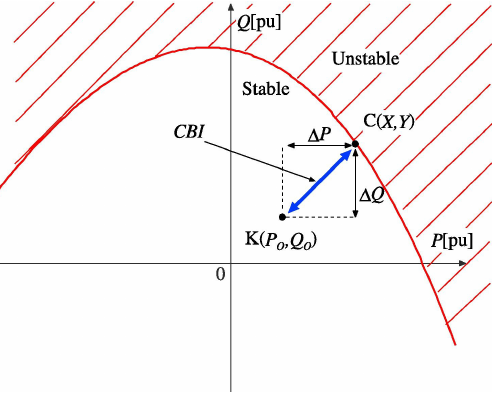
Figure 2. P - Q characteristics. (From Ref.